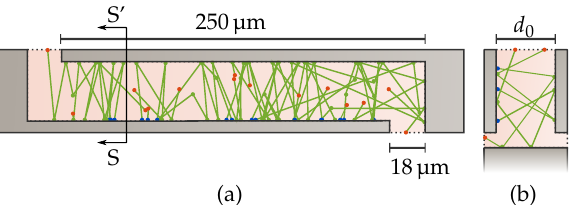
Figure 2. ( a ) Top view of typical 3D simulation result of a single set of capacitor plates ( d 0 = 30µm). Particles spawn at one of the plates (blue dots) and are tracked through their reflections (green dots) until they leave the cavity (red dots). ( b ) Cross-section view